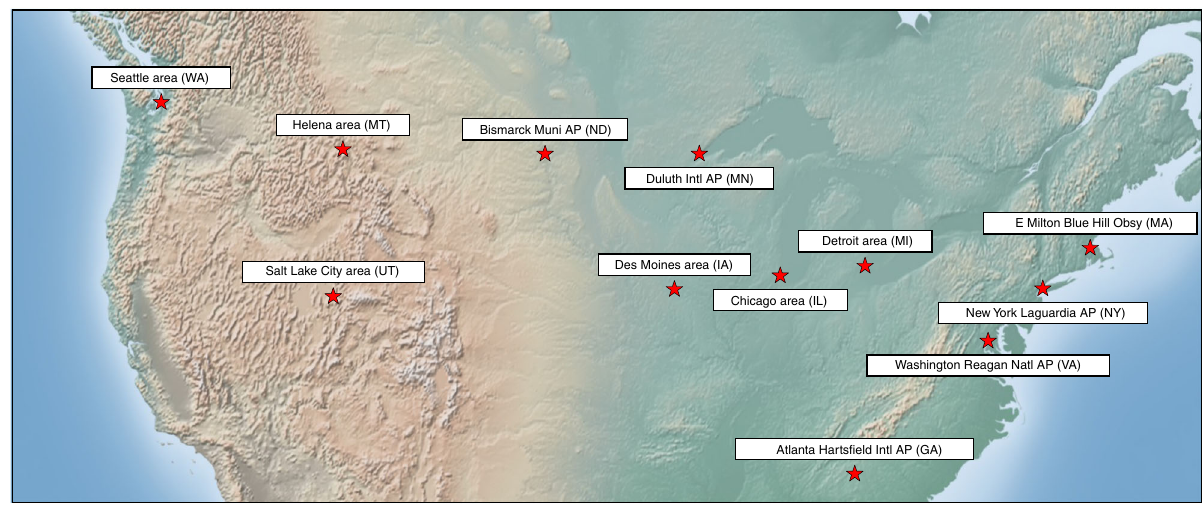
Fig. 1 Geographic locations of cites analyzed. We chose a geographically diverse set of 12 cities to analyze Arctic variability and severe winter weather, though we chose more cities in the northeastern and mid-western US where severe winter weather is more common than in other regions of the